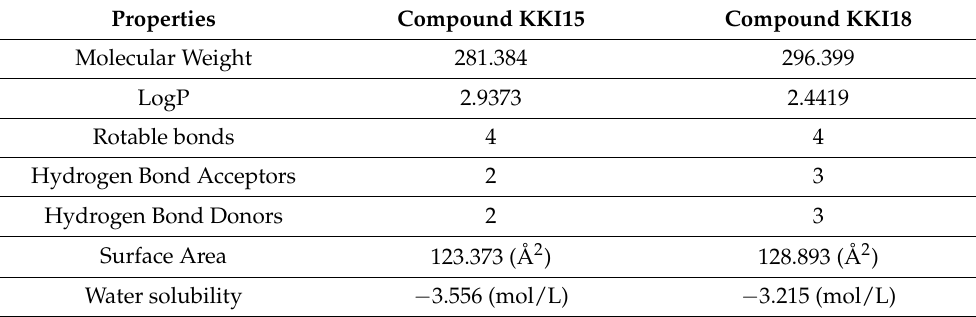
Table 9. The physicochemical parameters for compounds KKI15 and KKI18 .